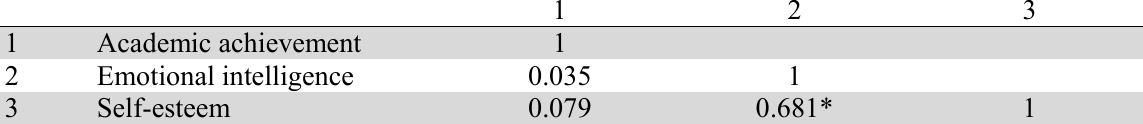
Correlation matrix of academic achievement, emotional intelligence, self-concept and self-esteem